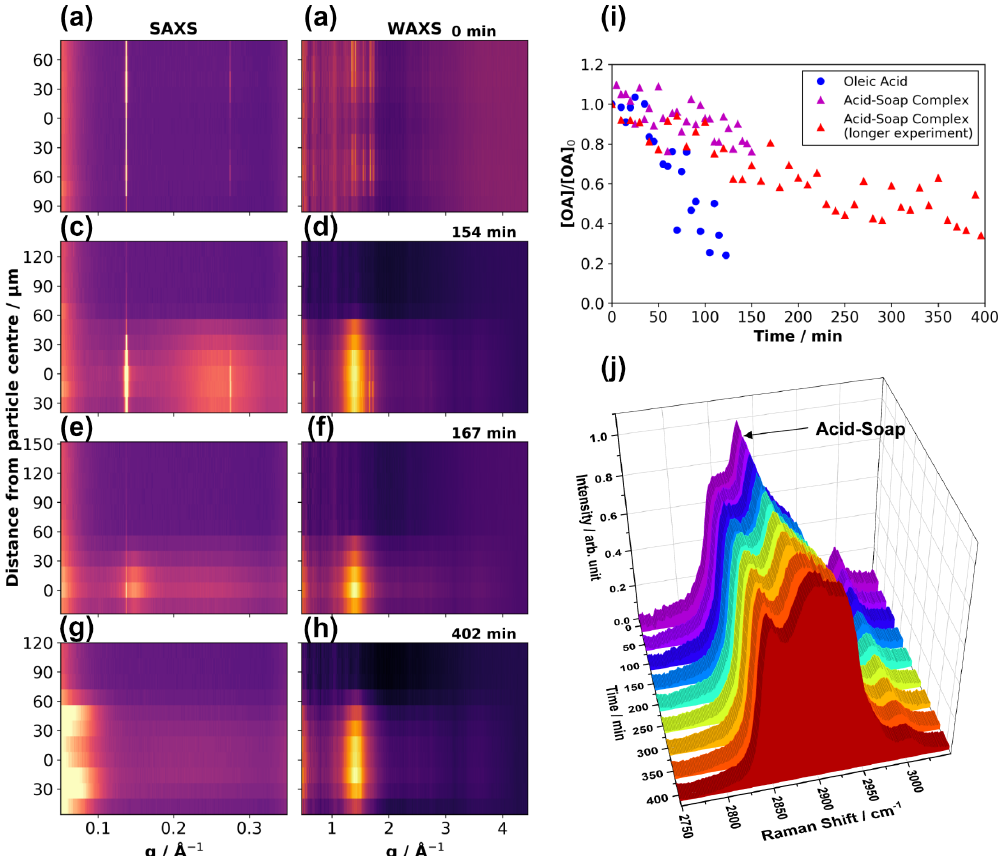
Figure 2. Vertical scans through the particle showing the effect of ozonolysis on self-assembly. Each row of plots (a) and (b) , (c) and (d) , (e) and (f) , and (g) and (h) shows simultaneous 1-D SAXS and WAXS scattering patterns vs. distance from the particle centre (measured in micrometres from what was deemed the particle centre from attenuation data) at increasing time exposed to ozone (labelled at the top right of every WAXS plot). The particle moved and possibly changed shape during the experiment; vertical movement is apparent from the SAXS and WAXS patterns. (i) Comparison of a levitated pure oleic acid droplet vs. a levitated acid–soap complex particle undergoing ozonolysis, measured by Raman microscopy – a longer ozonolysis experiment on a different levitated acid–soap complex particle is also presented, totalling two ozonolysis experiments on this proxy. (j) Evolution of the Raman spectra between 2750 and 3050cm − 1 of a levitated acid– soap complex during ozonolysis. (Particle size: ∼ 85µm (vertical radius) ×∼ 500µm (horizontal radius); [O 3 ] = 51.9 ±